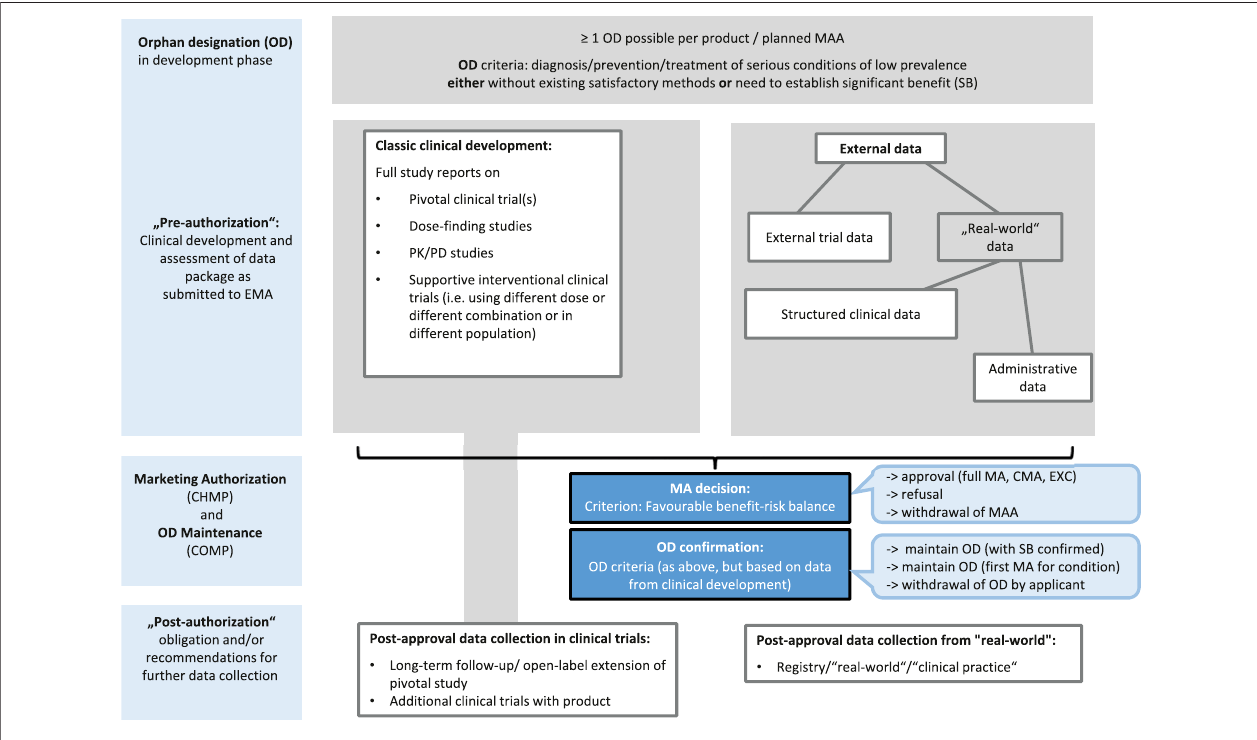
FIGURE1| Clinicaldevelopmentandregulatoryprocessesforproductswithorphandesignation.CHMP:CommitteeforMedicinalProductsforHumanUse;CMA: conditional MA, COMP: Committee for Orphan Medicinal Products; EMA: European Medicines Agency; EXC: MA under exceptional circumstances; MA(A): marketing authorization (application); PD: pharmacodynamic; PK: pharmacokinetic; OD: orphan designation; SB: signi fi cant bene fi